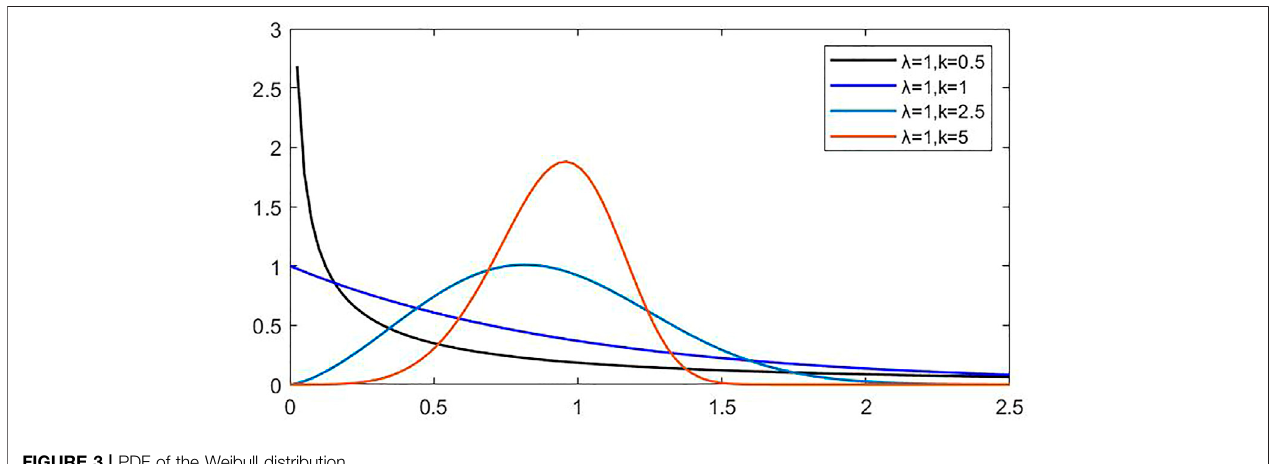
FIGURE 3 | PDF of the Weibull